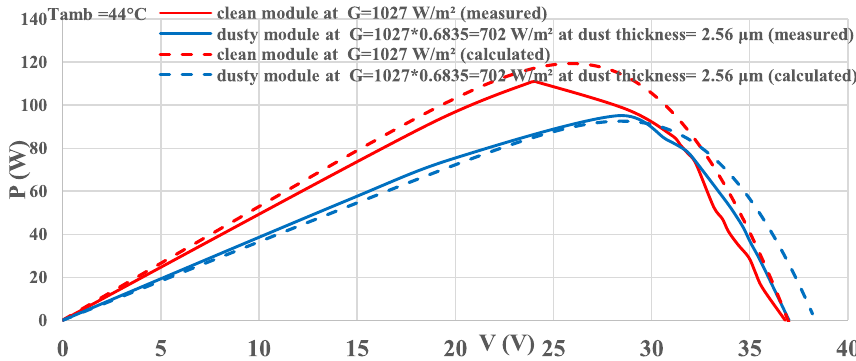
Fig. 8 Measured and calculated power‑voltage characteristic curves of dusty and clean modules at ambient incident radiation of 1027 W/m 2 http:// enerw in. com/ enerw in/